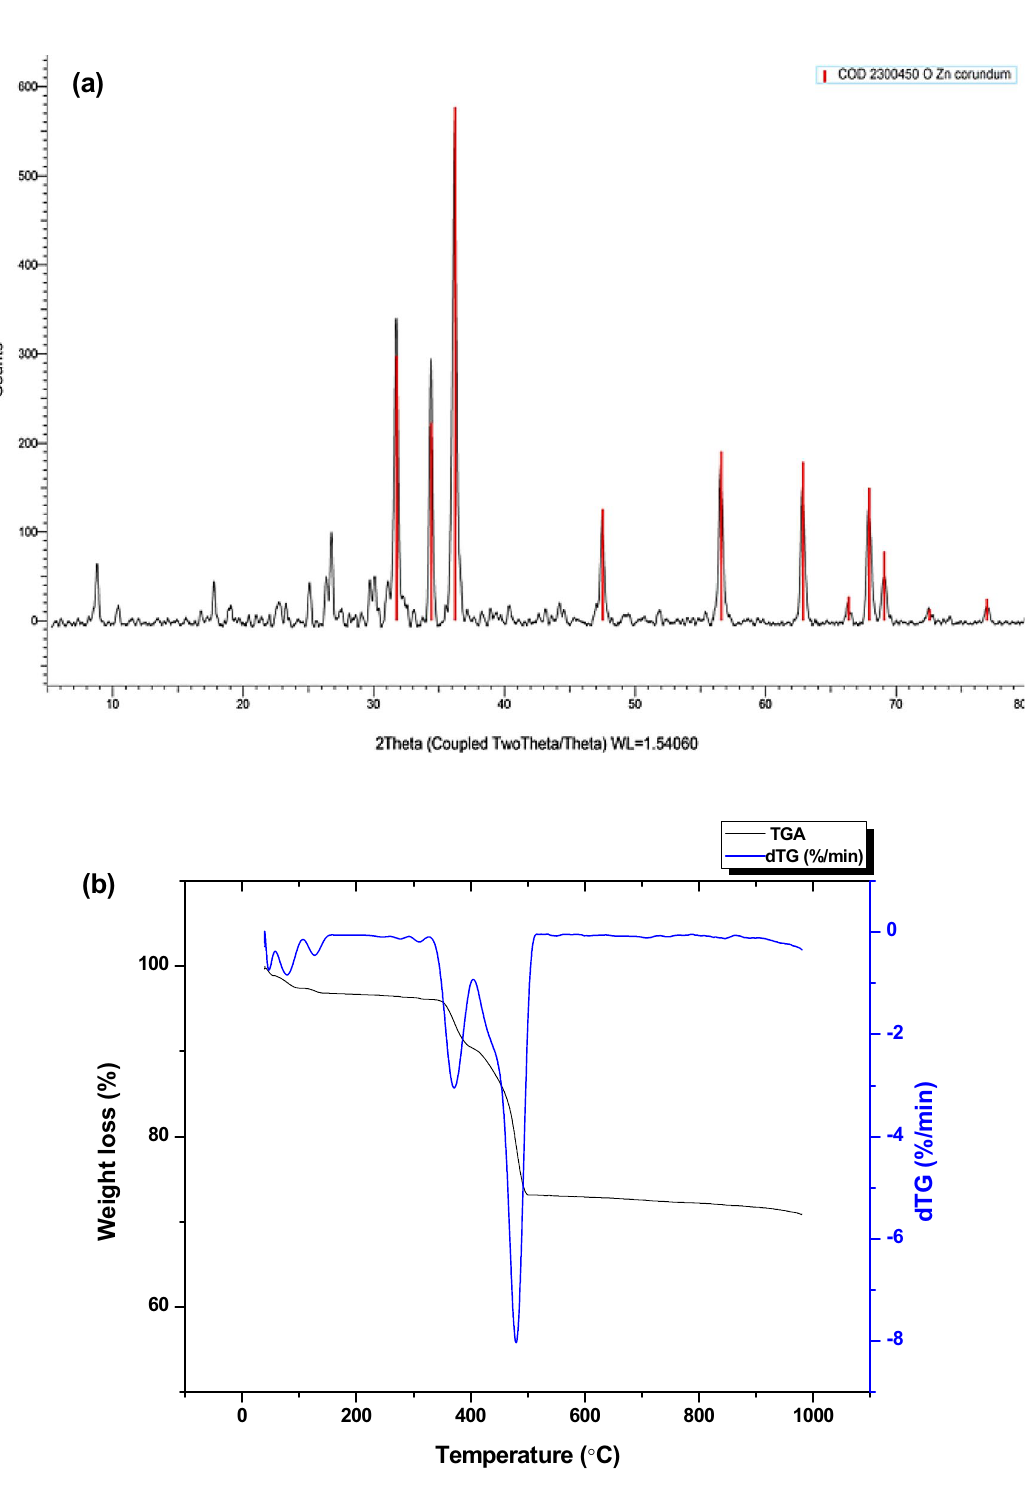
Figure 4. ( a ) XRD pattern and ( b ) TGA pattern of the phytosynthesized ZnO